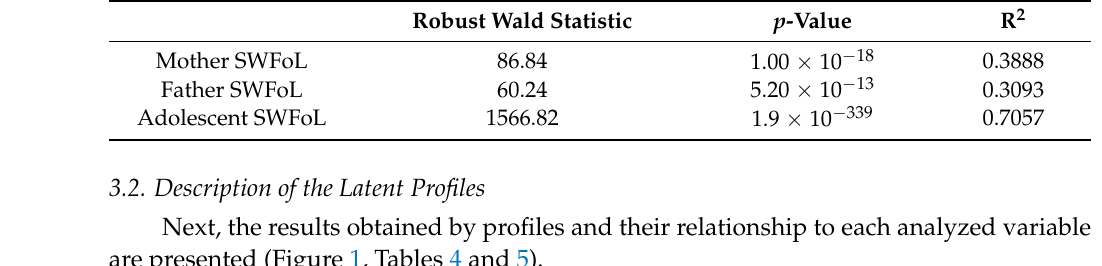
Table 3. Significance of the indicators for the four profiles.